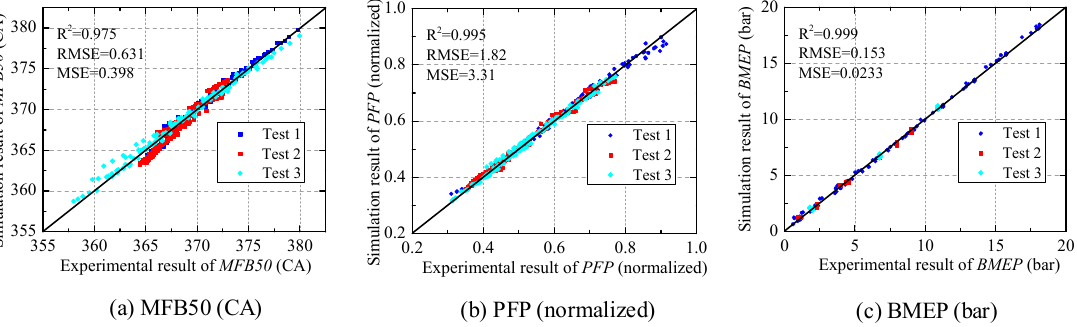
Figure 5. Predicted vs. experimental values of MFB50, PFP and BMEP for the improved physics-based model, considering the steady-state conditions.